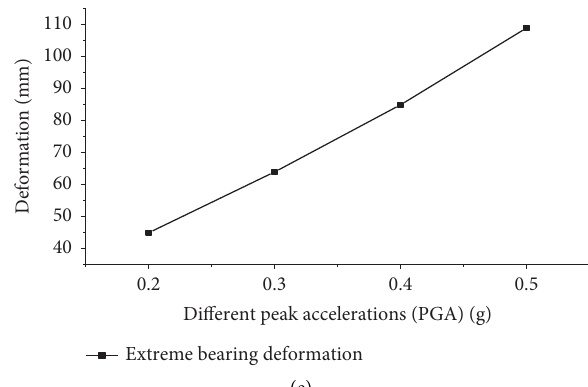
Figure 12: Maximum seismic response of aqueduct structure with diferent PGAs. (a) Transverse deformation of the aqueduct structure. (b) Maximum of the frst principal stress at point B. (c) Maximum of the frst principal stress at point E. (d) Maximum of the frst principal stress at point H. (e) Extreme bearing